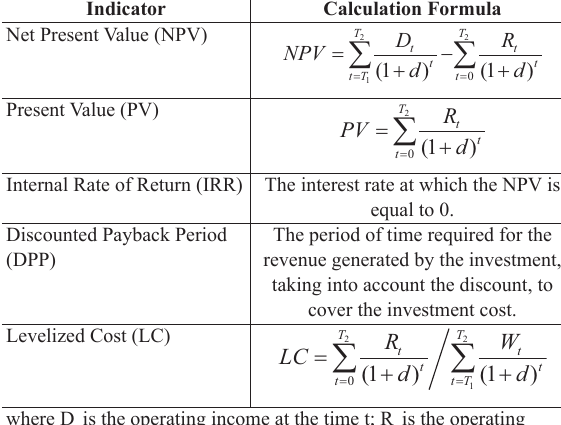
Table 1. Economic Performance Indicators.